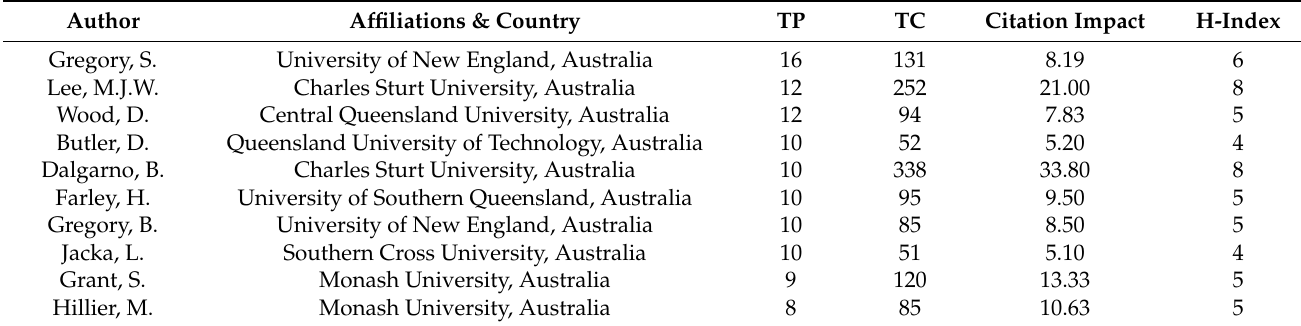
Table 2. Most prolific authors on virtual